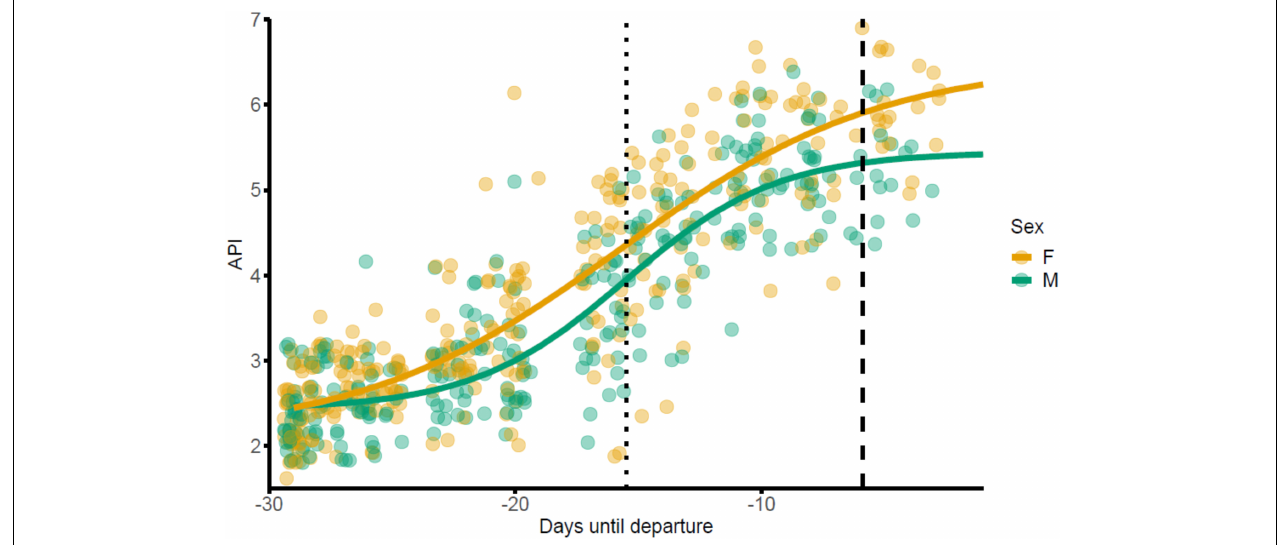
FIGURE 1 | Increase in body condition of brent geese during spring staging in Álftanes, Iceland, as measured by the abdominal profile index (API). Migration to breeding grounds was resumed en masse by brent geese on 30/05/17. Females are represented in orange and males in green. The dotted line is the point of inflection, when the rate of weight gain begins to slow ( x = 14–15/05/17). The dashed line represents the trough in the second derivative of the sigmoidal function, when the rate of weight gain begins to attenuate ( x =